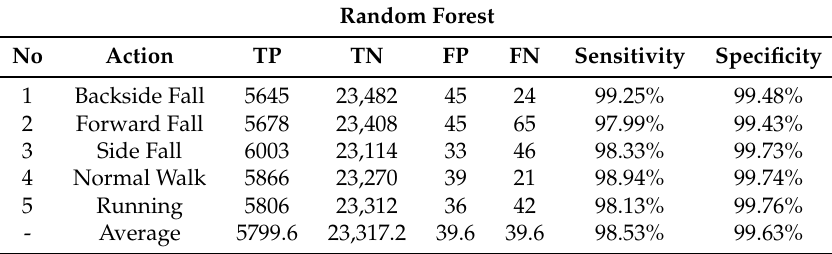
Table 5. Result analysis of Random